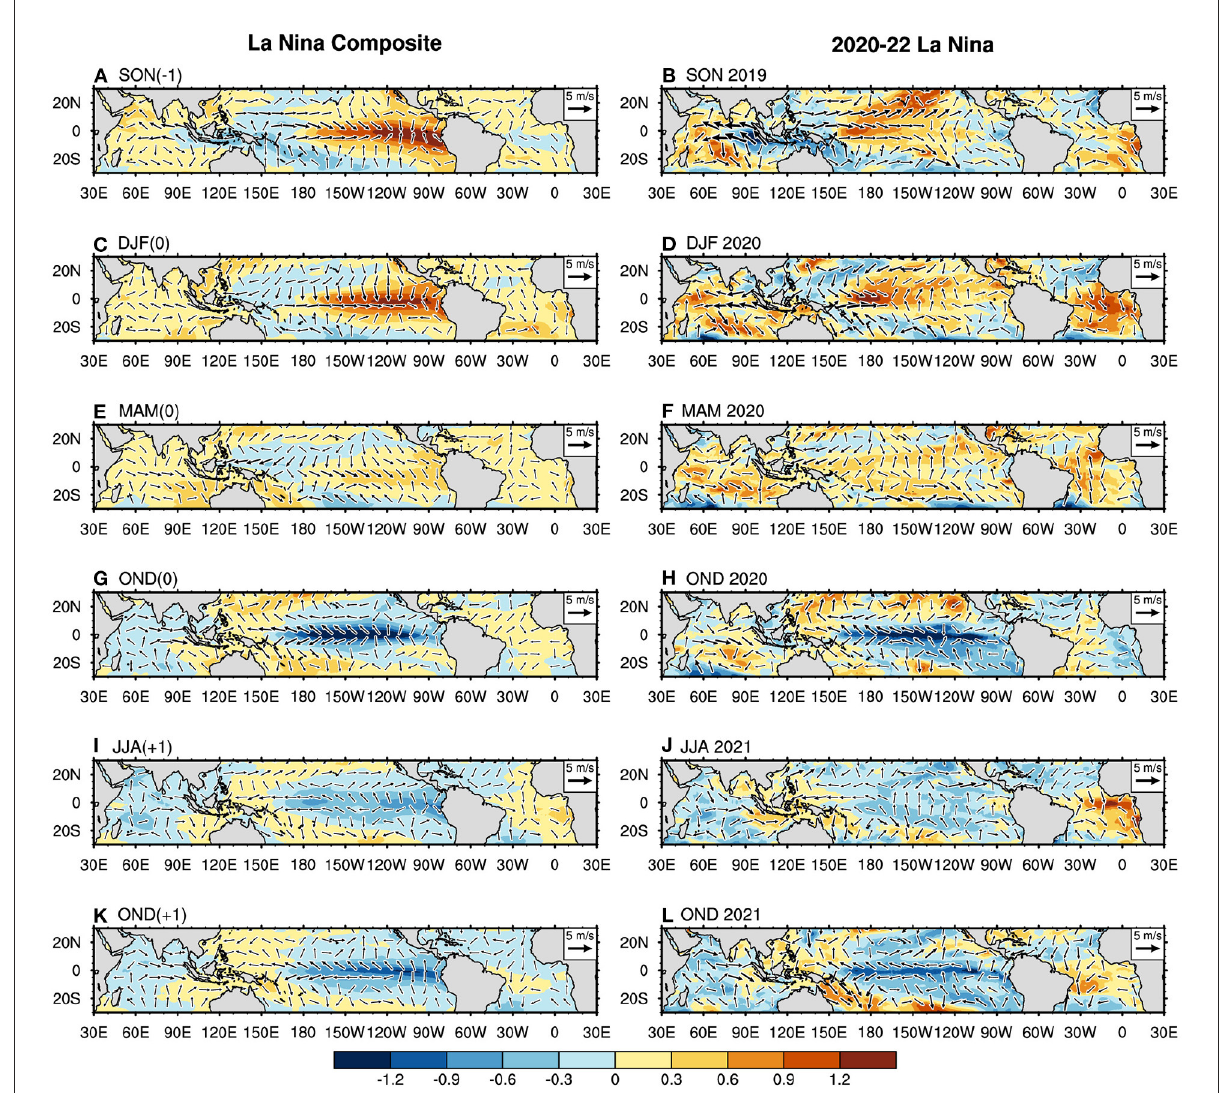
FIGURE2 Temporal evolutions of SST (in ◦ C indicated by color shading) and surface wind anomalies (vector) in the typical La Niña composite (left) and the 2020–2022 case (right) during the stage of (A,B) SON(-1), (C,D) DJF(0), (E,F) MAM(0), (G,H) OND(0), (I,J) JJA(+1), and (K,L) OND(+1). Anomalies are defined as deviations from climatological means, and linear trends are removed in each grid point. The reference vector (5 ms − 1 ) is in the upper right corner. As noted in parentheses after the season abbreviation, 0 indicates the first La Niña year, + 1 indicates the second La Niña year whereas − 1 indicates the preceding year of first La